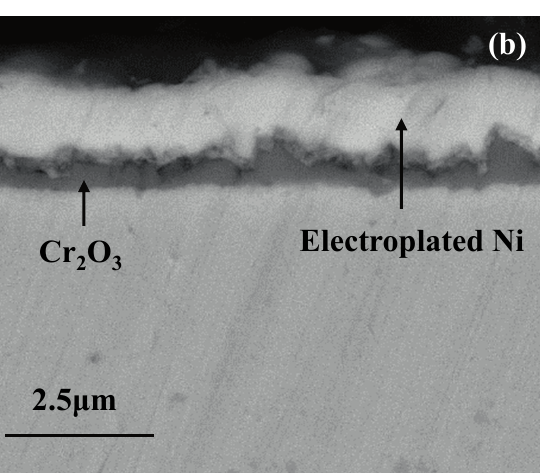
Figure 2. Oxidation kinetics of PMFe-40Ni-15Cr and MA Fe-40Ni-15Cr alloy at 1073–1173 K in 1:01 (cid:2) 10 2 kPa pure oxygen for 24 h: (a) normal plots and (b) parabolic plots.